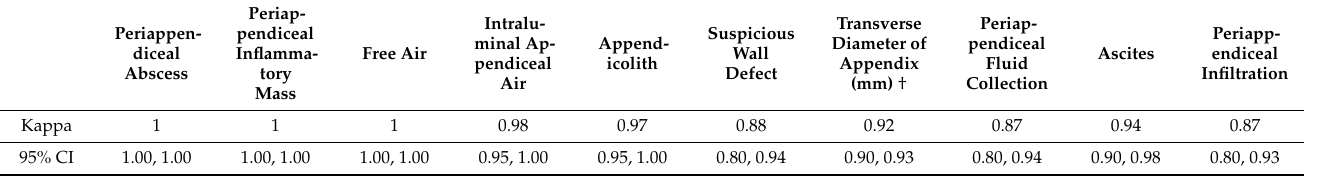
Table A1. Inter-observer agreement for CT